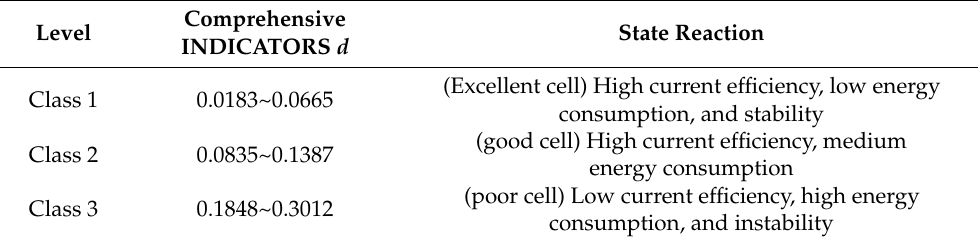
Table 2. Evaluation results of the status of aluminum electrolytic